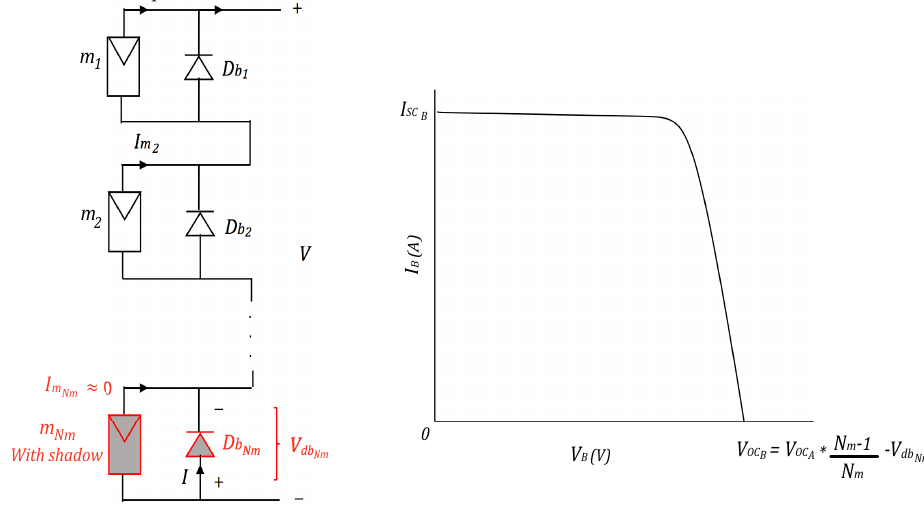
Figure 4. Left : Structure of a PV module formed by N m submodules, where N m − 1 are operating under uniform conditions and submodule N m is completely shaded ( I m I-V curve.